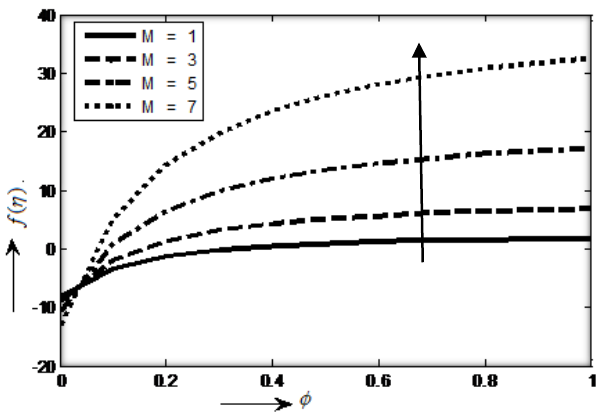
Figure 8. Variation of fluid velocity f (  ) against  for Magnetic parameters M (1, 3, 5, 7) by taking parameters  = 1.6, K = 0.8 and Re =